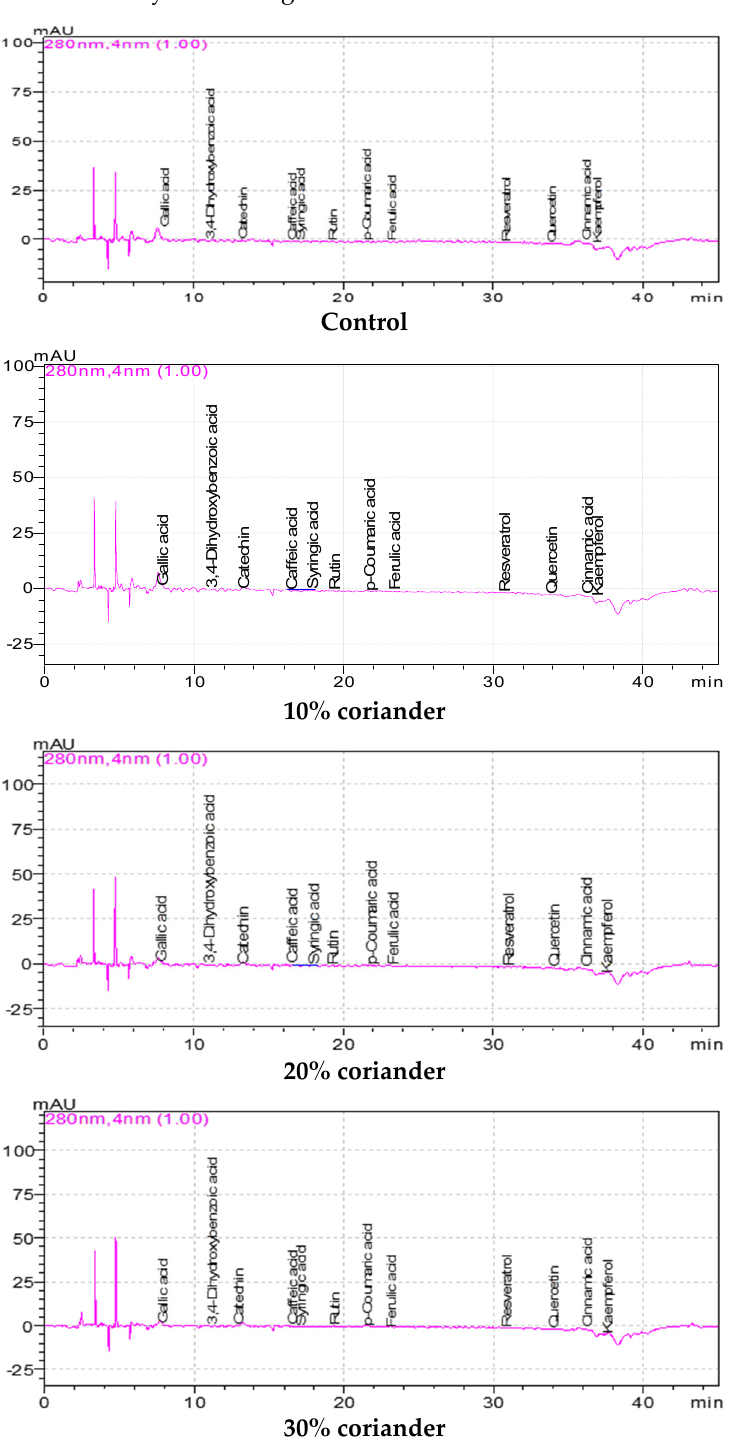
Figure 1. Phenolic chromatograms of bread samples enriched with coriander seed powder.